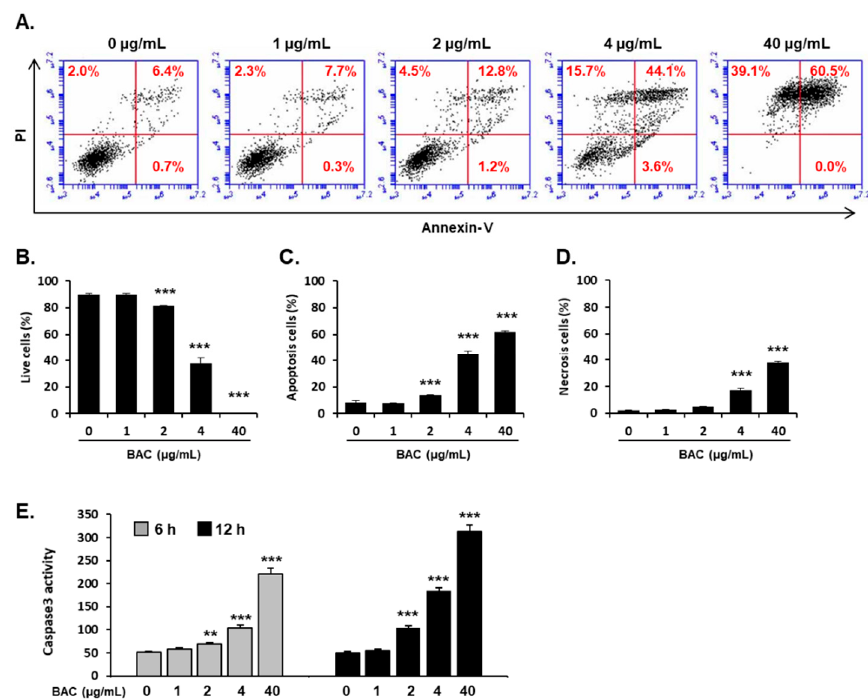
Figure 2. Induction of necrosis and apoptosis in H358 cells treated with BAC. Cells were treated with BAC for 24 h ( A – D ). ( A ) Fluorescence-activated cell sorting (FACS) analysis of propidium iodide (PI) uptake and annexinV binding in non-permeabilized cells (Lower-left, live cells; lower-right, early apoptotic cells; upper-right, late apoptotic cells; upper-left, necrotic cells). Quantification of ( B ) live cells, ( C ) apoptotic cells, and ( D ) necrotic cells. ( E ) Caspase-3 activity in the cells treated with BAC for 6 h and 12 h. The results are presented as the mean ± SD of triplicate experiments. Statistical significance was determined by Student’s t-test (** p < 0.01, *** p < 0.001, compared to untreated cells).